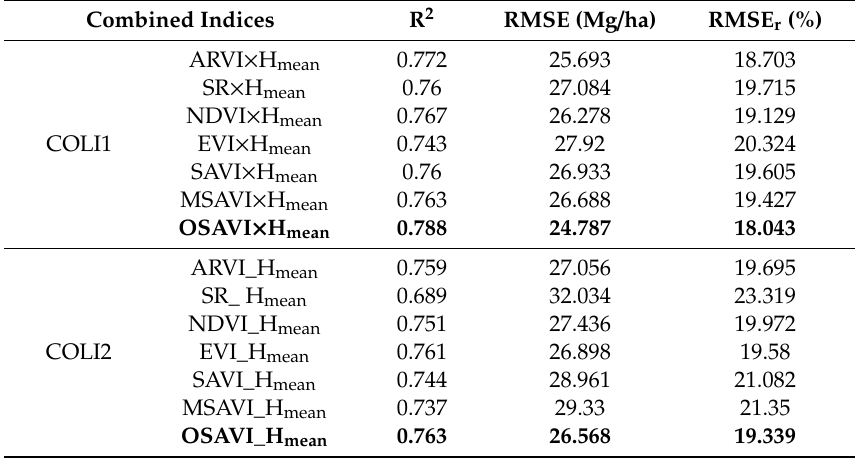
Table 5. Accuracy assessment of the models with input variables of COLIs.